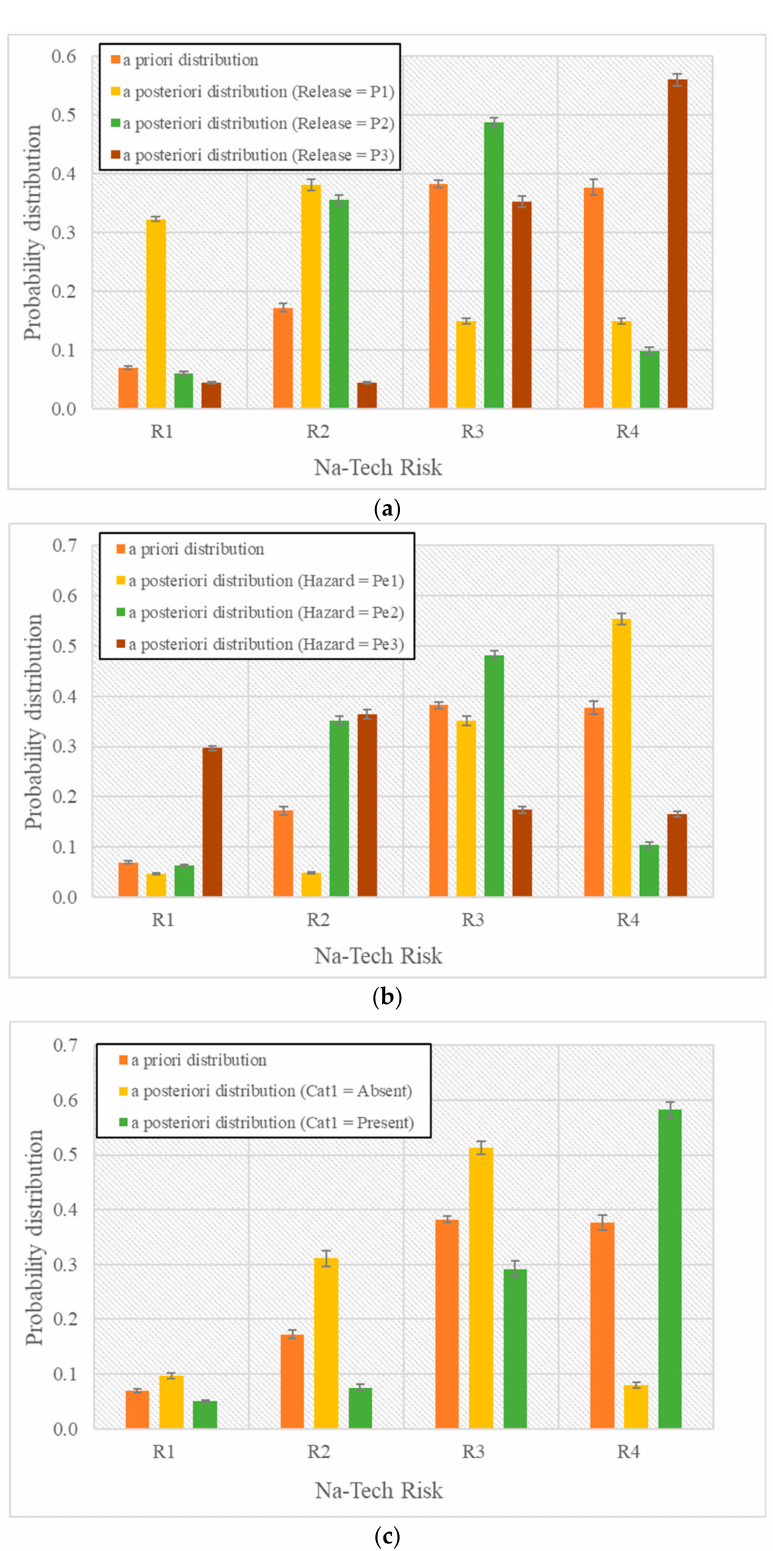
Figure 8. Cross-validation results for Na-Tech Risk: average a priori and a posteriori probability distribution when ( a ) the node Release assumes 100% at each state ( b ) the node Hazard assumes 100% at each state and ( c ) the node Workers (Cat1) assumes 100% at each